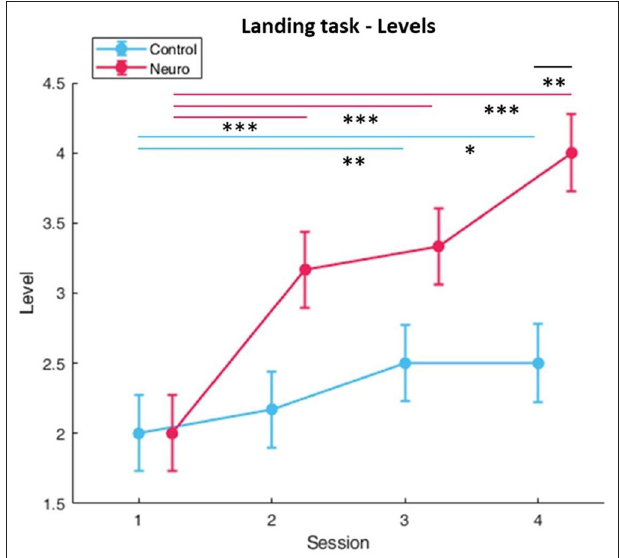
FIGURE 4 | Training levels reached for landing task over each session per experimental group. Neuroadaptive group reached significantly higher levels (whiskers are SEM, * p < 0.05, ** p < 0.01, *** p < 0.001).